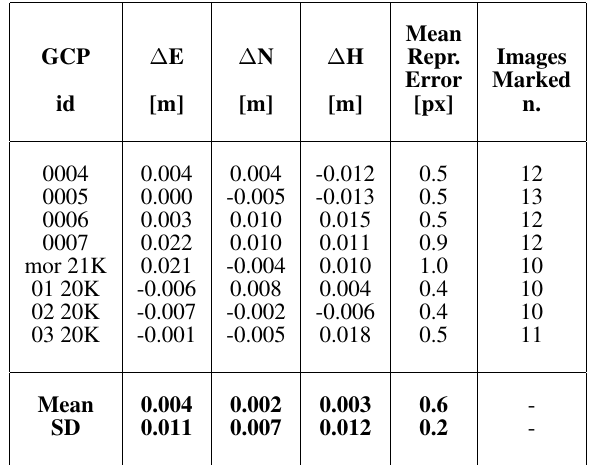
Table 2. Assessment of the standard photogrammetric pipeline - 2020 block.